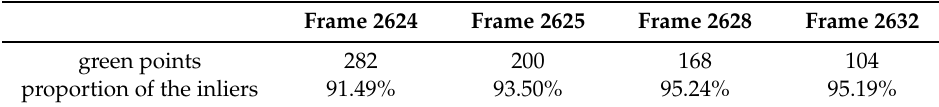
Table 1. Number of the green points and proportion of the inliers.